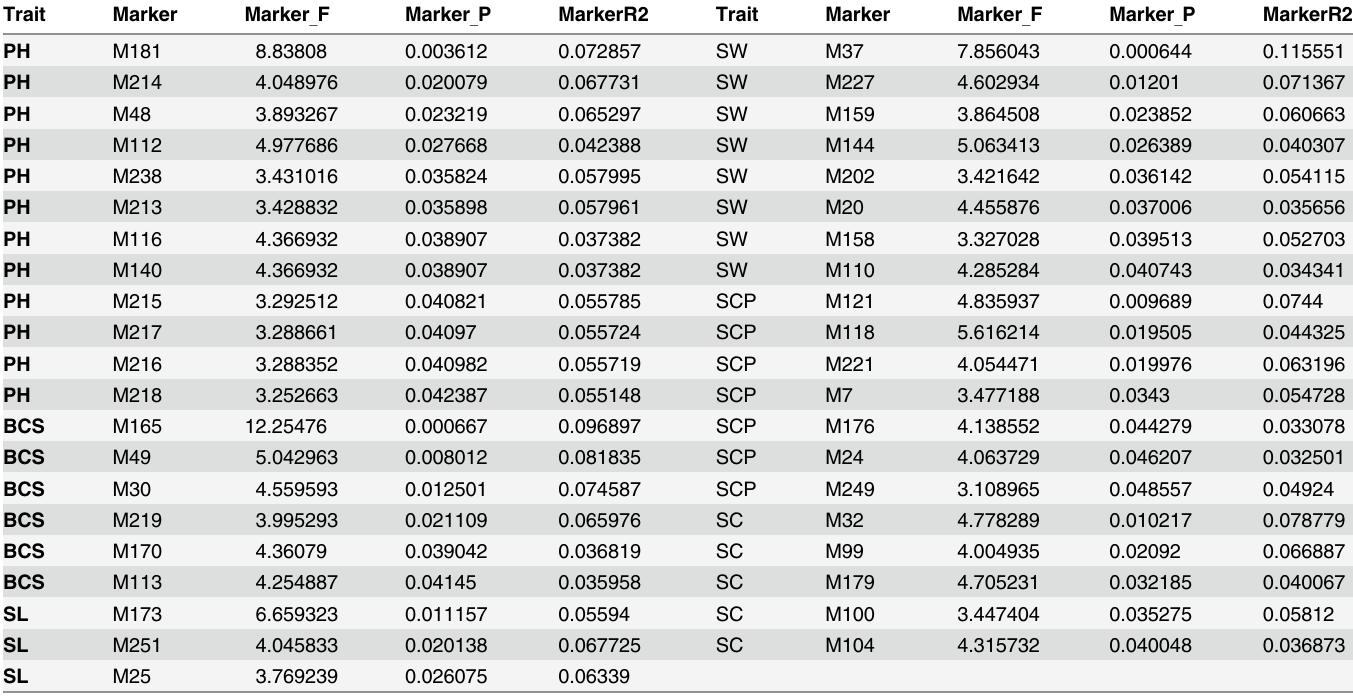
Table 2. Association of SSR markers with percentage of reduction of single agronomic traits of tall fescue accessions by corrected P values ( P < 3.5×10 − 4 ).